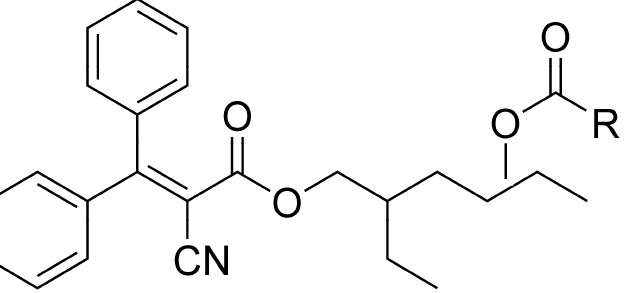
Figure 2. General structure of OC–fatty acid conjugates. The substitution site is undetermined, and the R group is a saturated or unsaturated linear alkyl chain (see Table 3).